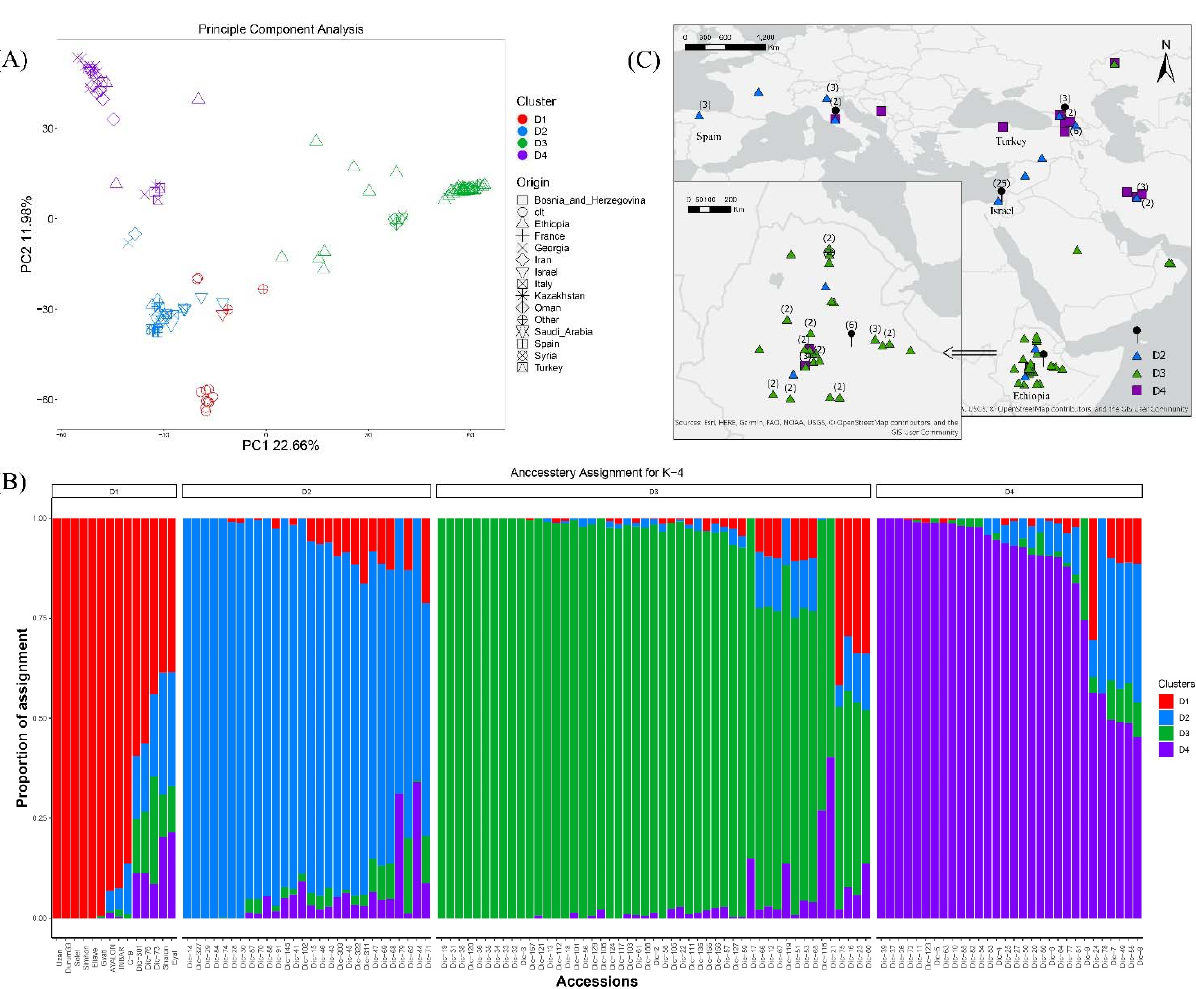
Figure 1. Genetic characterization of emmer wheat collection. ( A ) Principal component analysis (PCA) of individuals from various regions in Levant, Eurasia, and Ethiopia. The scatter plot consists of the two first PCs selected based on their highest eigenvalue. Country of origin is indicated with different shapes and their associated clustered (based on highest assignment in the sNMF analysis) is indicated with different colors. ( B ) A bar plot for the assignment of T. dicoccum and T. durum accessions to clusters as identified by the sNMF analysis for K = 4. In the bar plot, each bar corresponds to accession, and colors represent the assignment to each cluster. ( C ) The geographic distribution of the emmer wheat accessions. At the bottom left is a zoom-in view of accessions from Ethiopia. In the plot, different symbols and colors represent the assignment of accessions to a cluster, and the pinpoints denote accessions for which geographic coordinates were not available. Numbers in parentheses indicate different sampling sites in the same country of origin, cultivated accessions are not included.